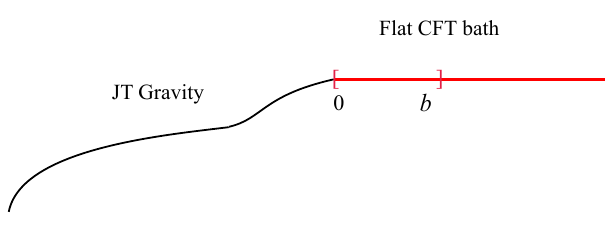
Figure 12 . JT gravity plus CFT matters is jointed with a flat CFT